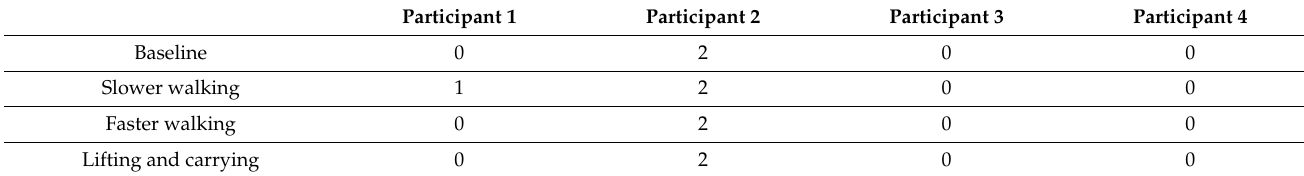
Table 4. Thermal Comfort results for each participant for the Loose Leg Sleeve, where − 3 represents very uncomfortable, − 2 slightly uncomfortable, − 1 uncomfortable, 0 neutral, 1 slightly comfortable, 2 comfortable, and 3 very comfortable.